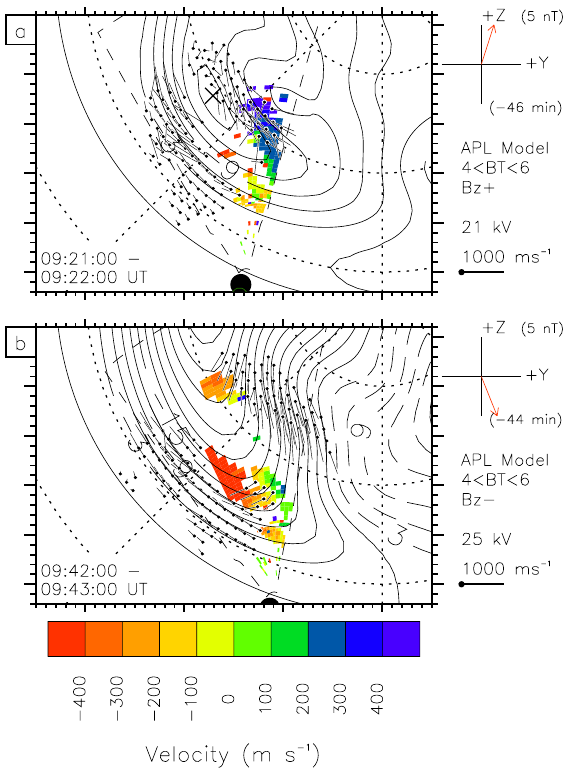
Fig. 5. Two scans of line-of-sight velocity data from the north- ern hemisphere King Salmon radar, which is conjugate to TIGER Unwin (see Fig. 1). This data is shown in the same format as the left-hand panels of Fig. 4, and again has the southern hemisphere vectors and potential contours superposed, for comparison with the northern hemisphere